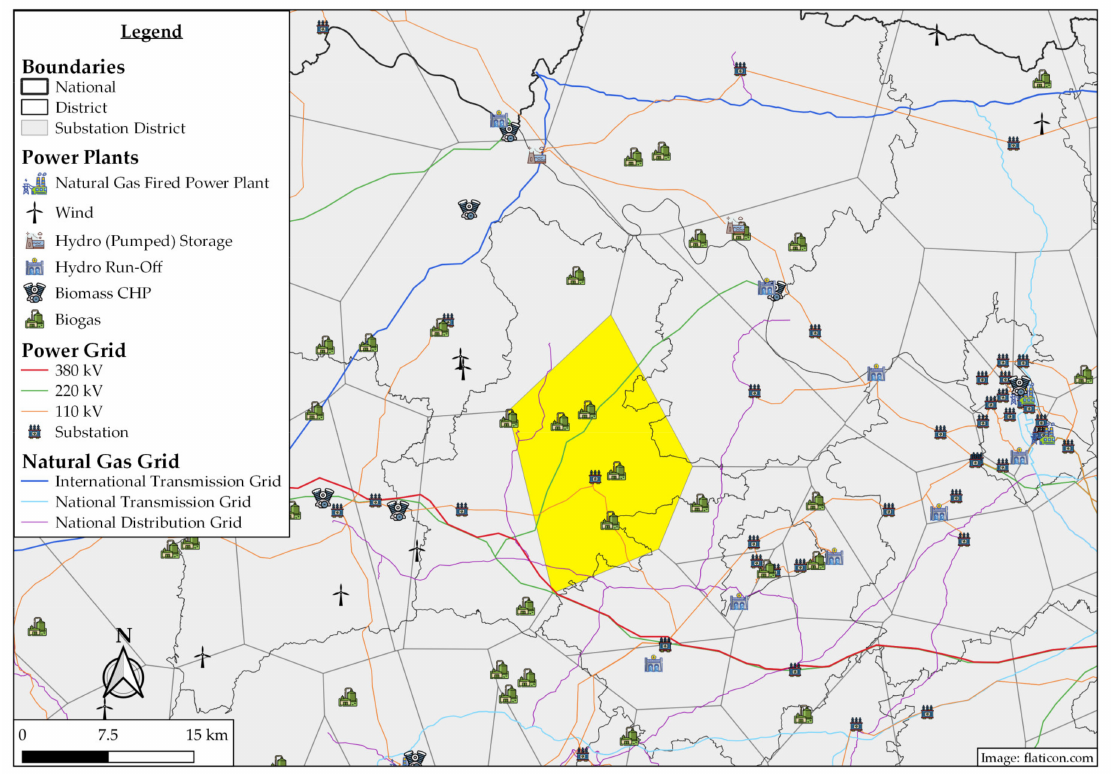
Figure 13. Example of Austria’s energy infrastructure and power plants